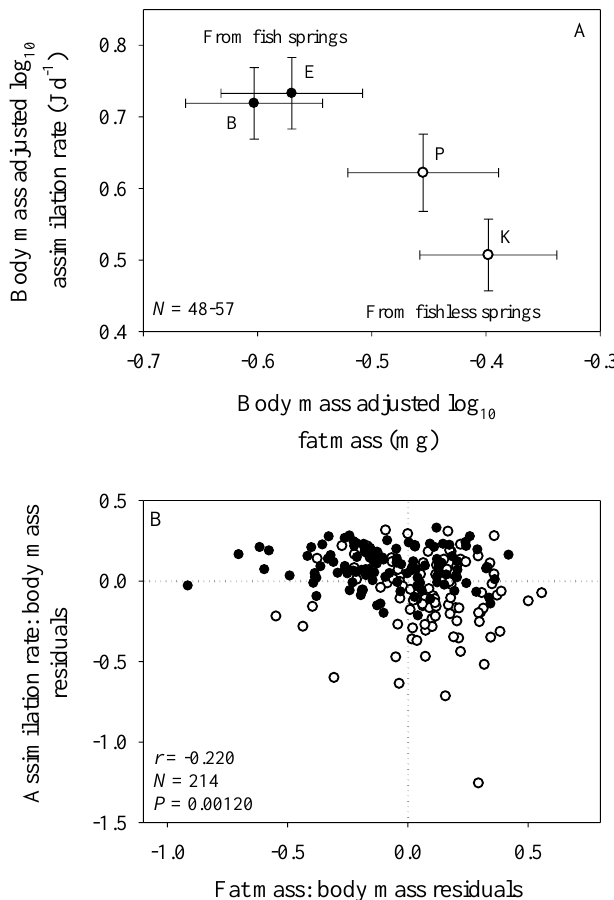
Figure 2. Assimilation rate as a function of fat mass in four populations of the amphipod Gammarus minus , two from springs with fish (solid circles) and two from springs without fish (open circles) (based on data in Supplementary Materials). ( A ) Shown are mean values ( ± 95% confidence intervals) adjusted to dry body mass by ANCOVA for each population and the range of sample sizes ( N ) among all four populations. ( B ) Shown are individual values expressed as residuals from least squares regressions against dry body mass for all four populations collectively. Shown are the correlation coe ffi cient ( r ), sample size ( N ) and probability that the correlation between the residuals of assimilation rate and fat mass is due to chance ( P